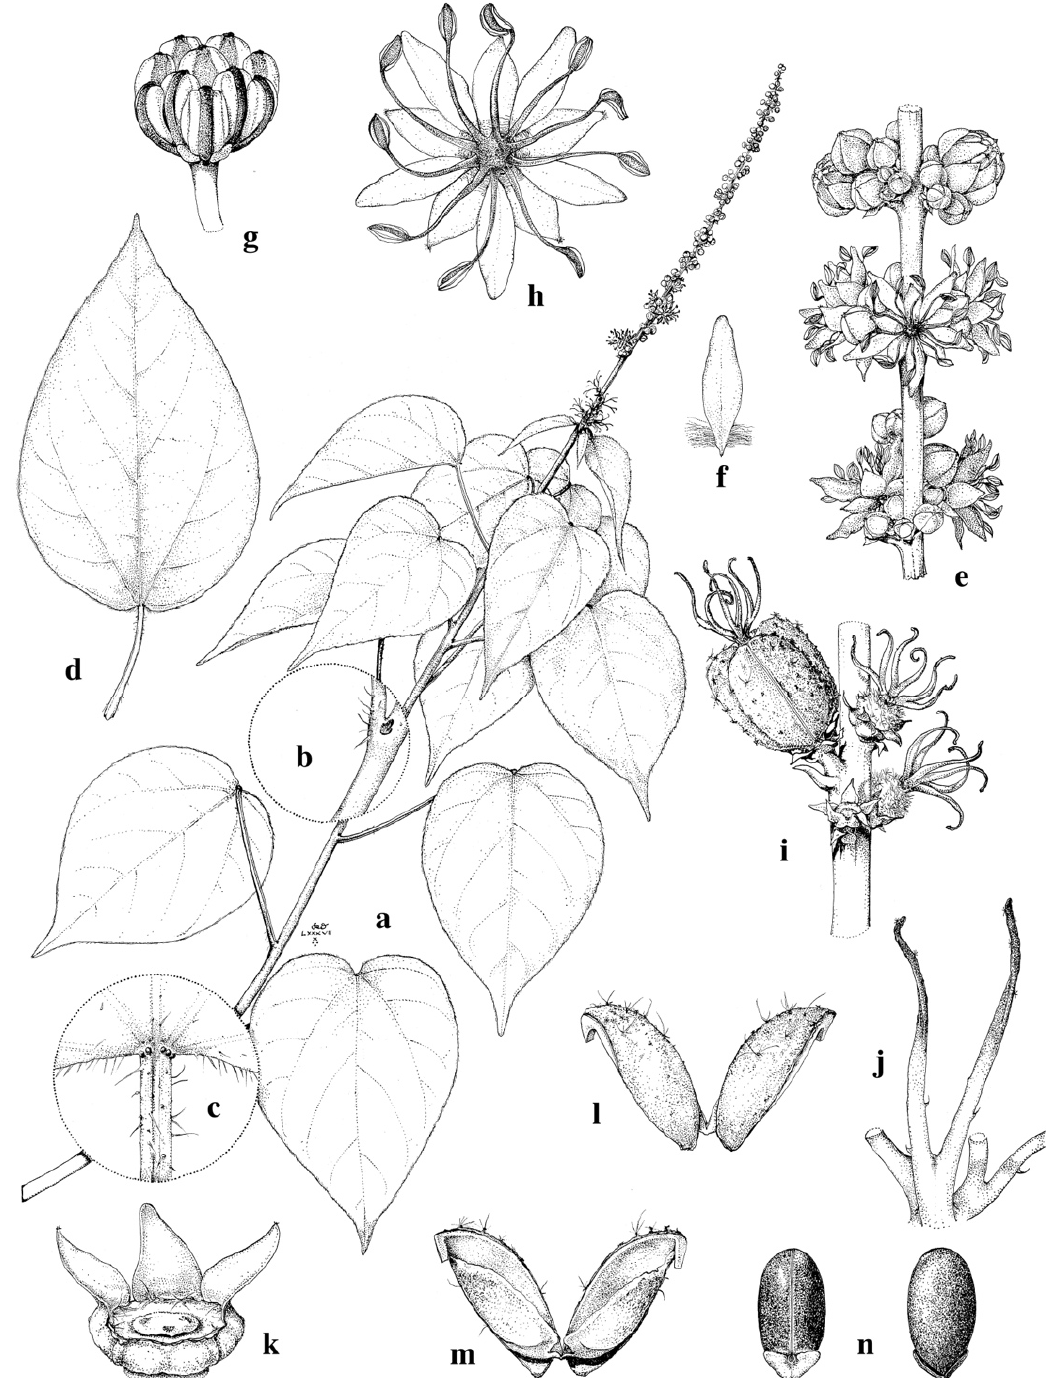
Figure A17. Croton adspersus ( a ) Flowering branch. ( b ) Stipule. ( c ) Leaf base and distal portion of the petiole showing small colleters. ( d ) Leaf. ( e ) Staminate portion of the inflorescence. ( f ) Petal. ( g ) Inflexed stamens with sepals and petals removed. ( h ) Staminate flower. ( i ) Pistillate portion of the inflorescence. ( j ) Divided styles. ( k ) Base of the female flower with the ovary and two sepals removed. ( l , m ) Dehisced fruit cocci. ( n ) Seed, ventral (left) and dorsal (right) views. Illustrated by